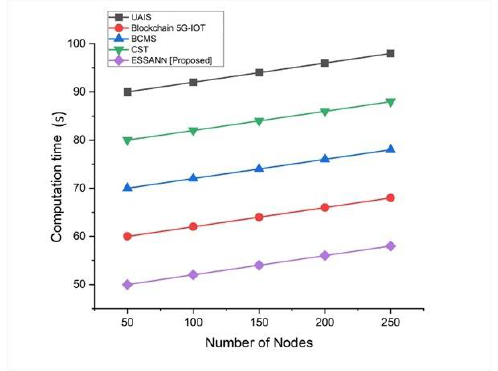
Figure 6. Comparison of computation time [23 – 26].